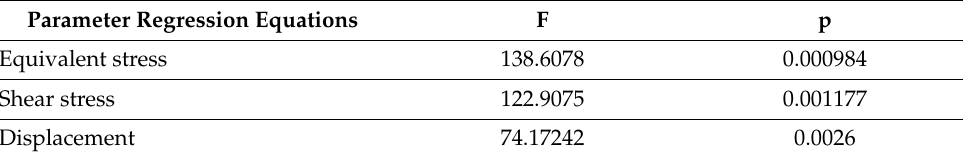
Table 6. The values of F and p, respectively, for the regression equations. Parameter Regression Equations